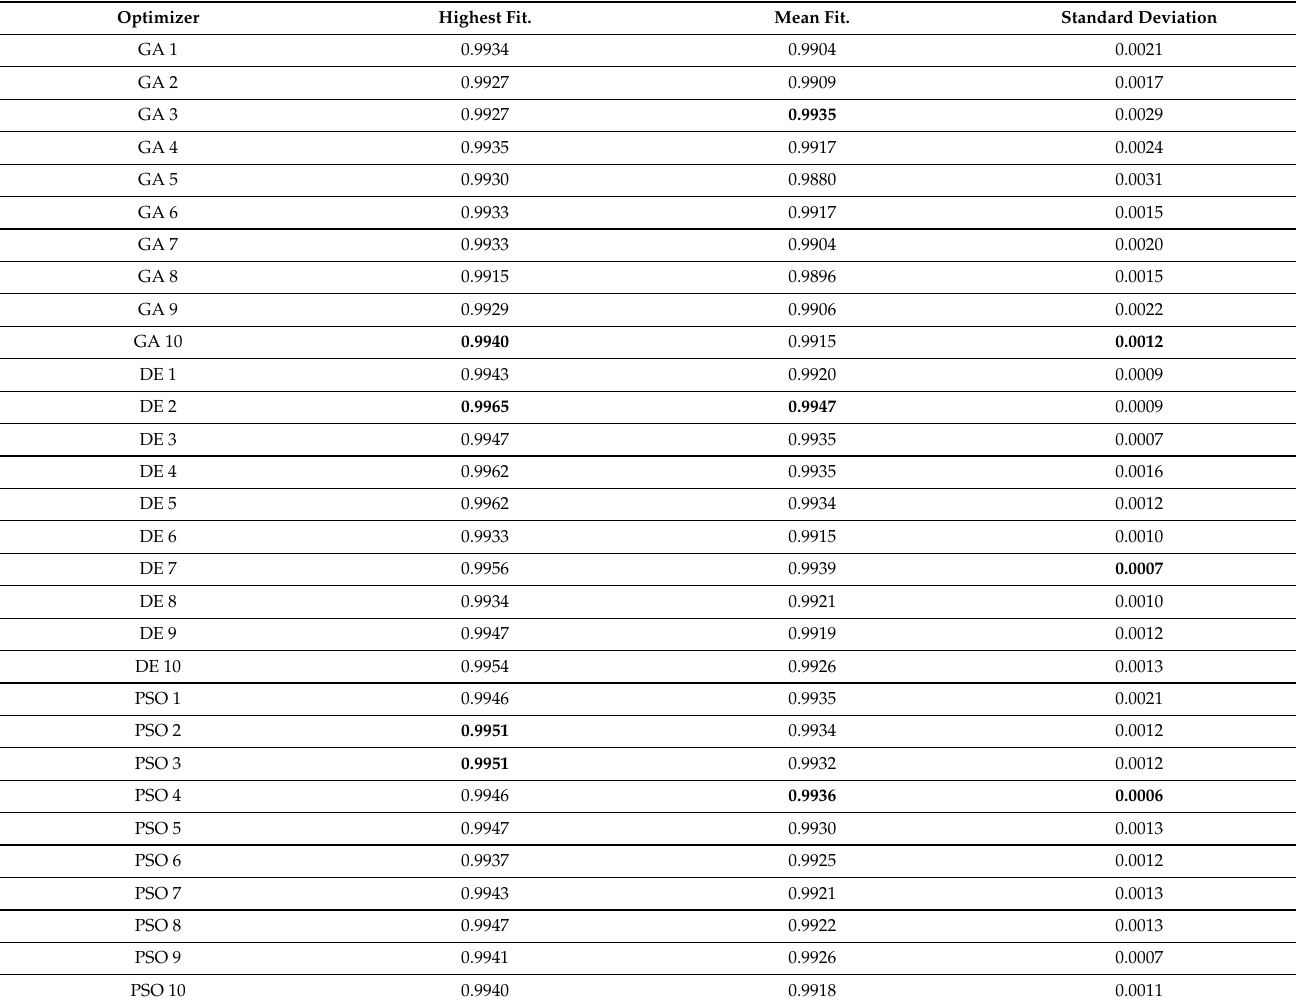
Table 2. Fitness values for different variations of GA, DE, and PSO. Highest